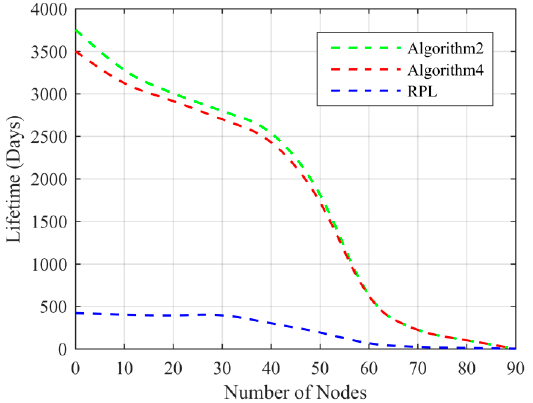
Figure 9. Network lifetime in different size.